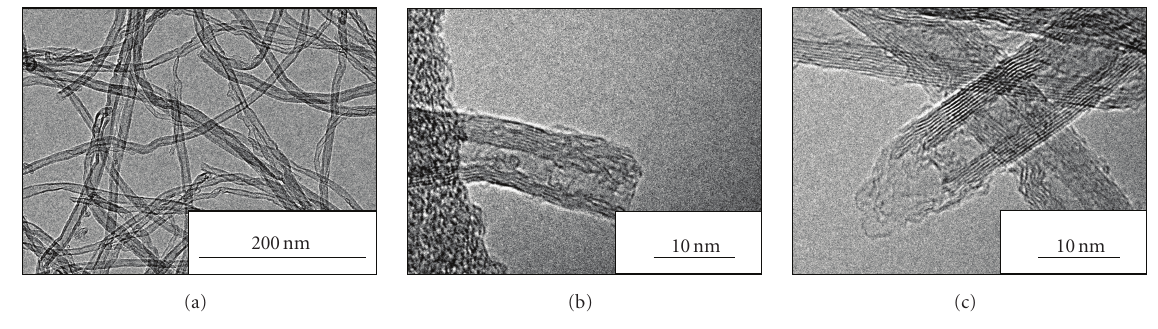
Figure 3: TEM micrographs of